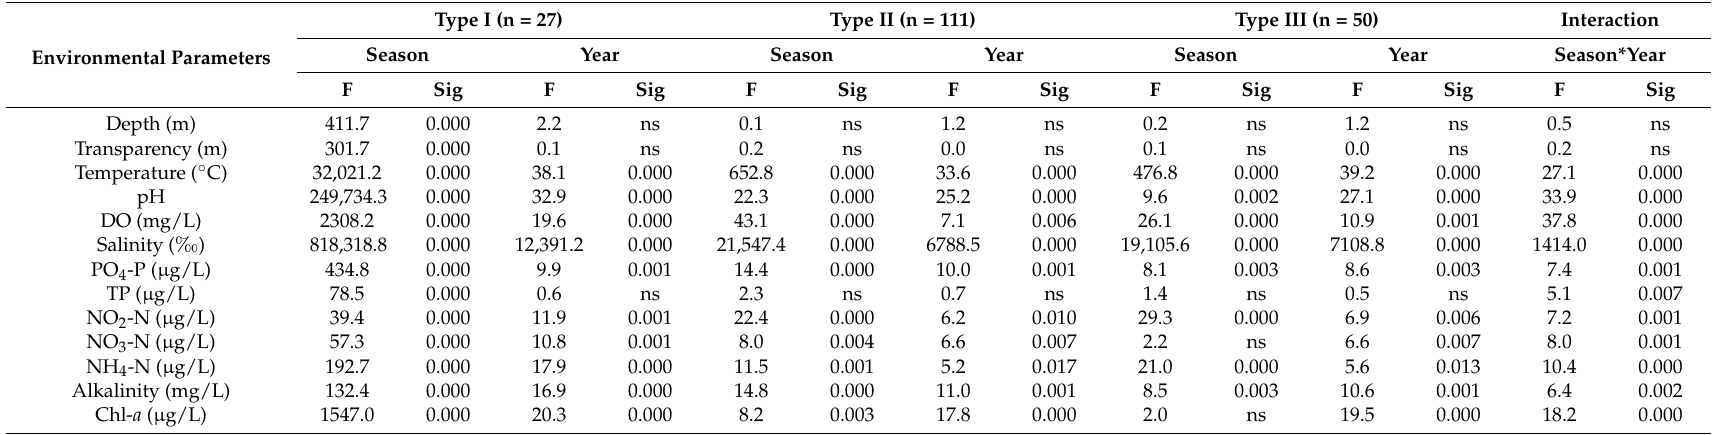
Table 1. Analysis of variance with the effects of the factors of season, year and their interactions (Season*Year) on the environmental parameters of three lagoon types of Western